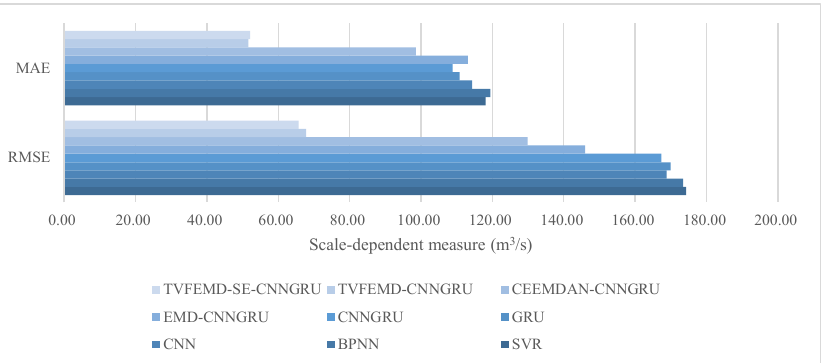
Figure 9. Histogram of metrics MAE and RMSE .